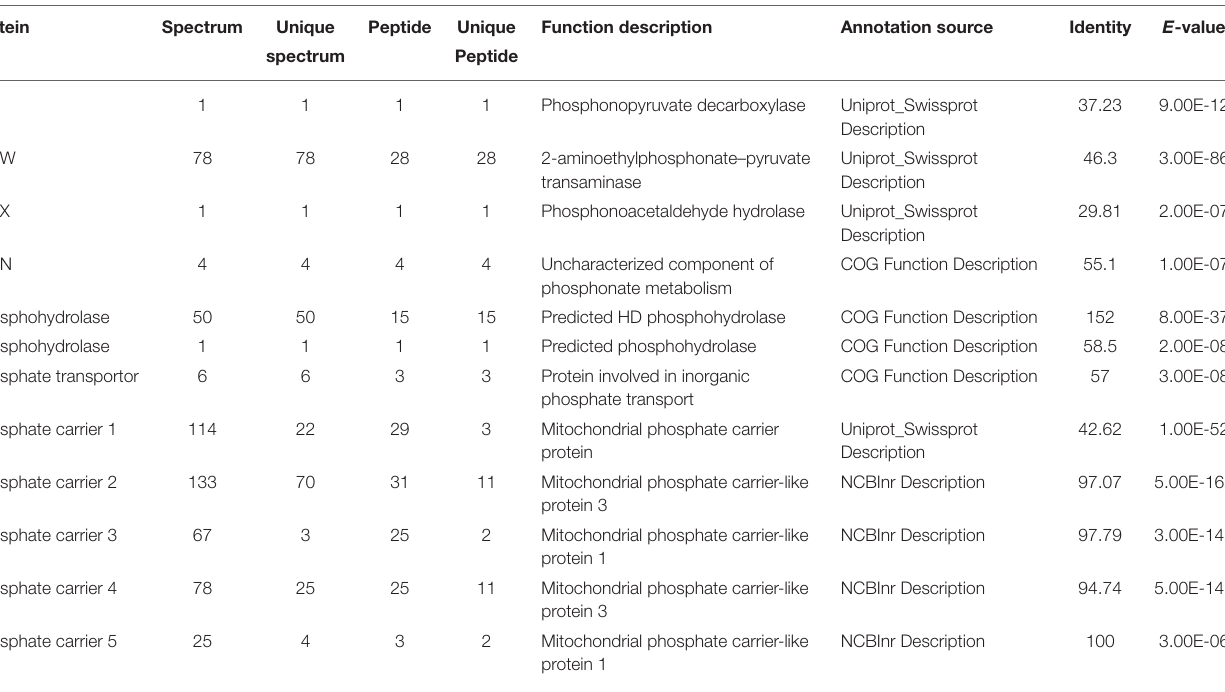
TABLE 2 | LC-ESI-MS/MS analysis results and function description of some proteins related to phosphonate metabolism and phosphate transportation. Protein Spectrum Unique Peptide Unique Function